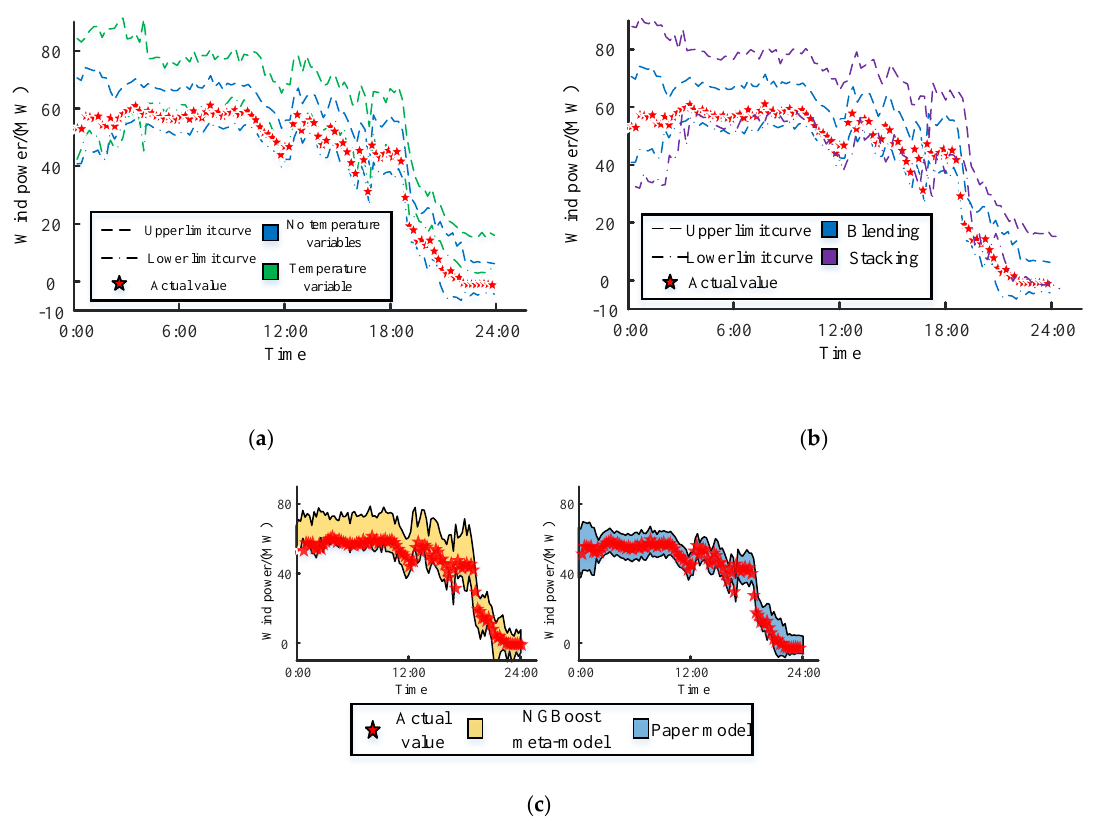
Figure 4. Improved model validity comparison verification. ( a ) Comparison with and without data preprocessing; ( b ) The fusion model comparison; ( c ) The comparison of model.